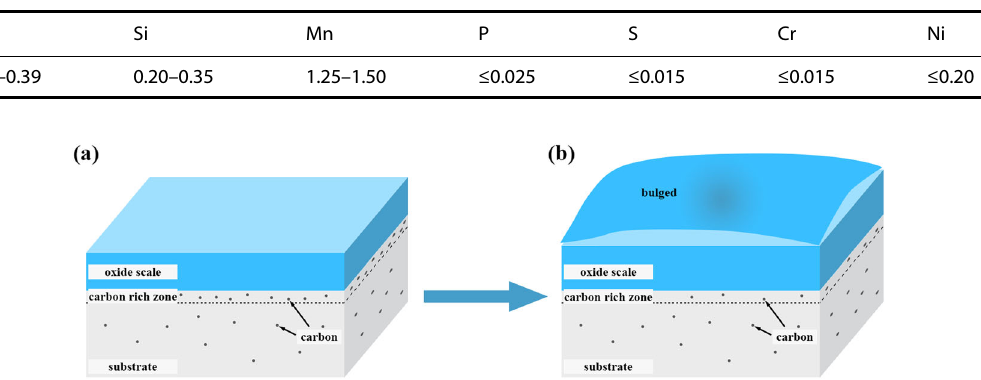
Table 1. Nominal composition of 37Mn5 steel